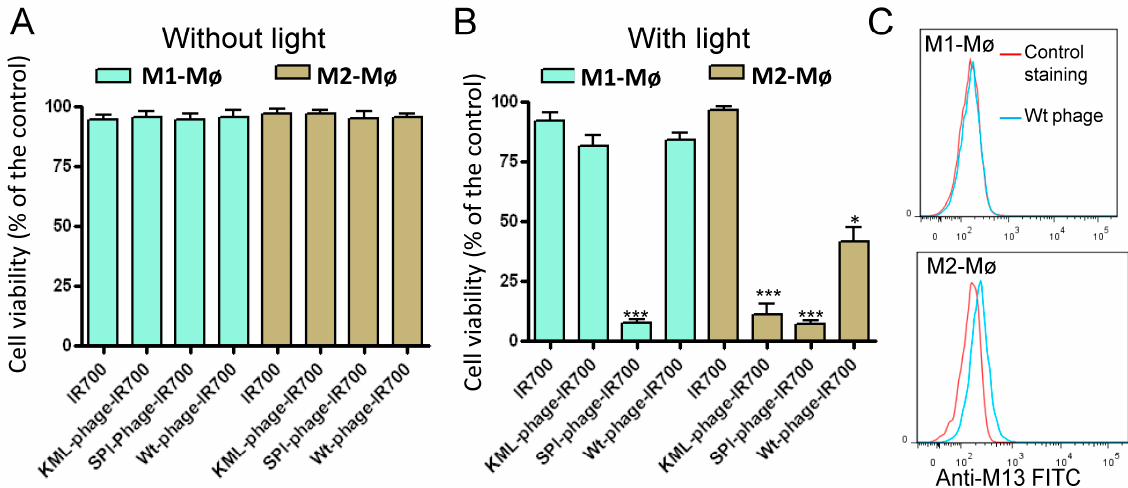
Figure 9. Analysis of the phage-IR700 conjugate photocytotoxicity by MTS assay. M1 and M2 macrophages were incubated with IR700 (50 nM) or phage-IR700 conjugates (10 7 TU/mL, with approximately 2250 IR700 molecules/phage) at room temperature for one hour. After washing, the cells were not ( A ) or exposed ( B ) to light (35 J/cm 2 at power density of 17 mW/cm 2 ) and then incubated at 37 °C for 16 h. After, cell viability was measured by MTS assay. As controls, the phage displaying the SPI peptide (SPI-phage-IR700) and wild phage (Wt-phage-IR700) were included. Data are expressed as percentage of the control cells (untreated) and are from triplicate determinations. Data are representative of 3 independent experiments. * p < 0.03, *** p < 0.001. ( C ) Analysis of the wild type (Wt) phage interaction with M2 macrophages. The cells were incubated with the Wt phage (10 7 TU/mL) and then analyzed by flow cytometry. Binding was detected using FITC conjugated an anti-M13 monoclonal antibody.